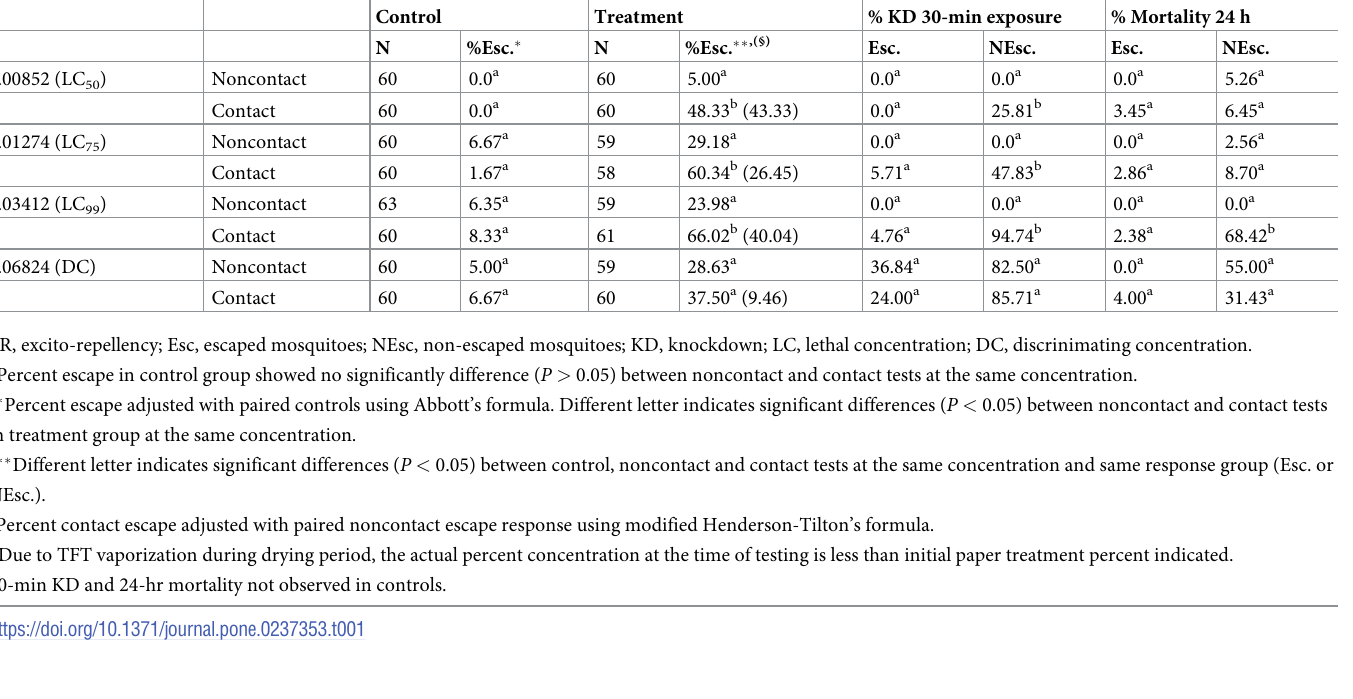
Table 1. Mean percent escape response and percent mortality of Ae . aegypti (USDA) exposed to TFT in ER assays. % Concentration† ER